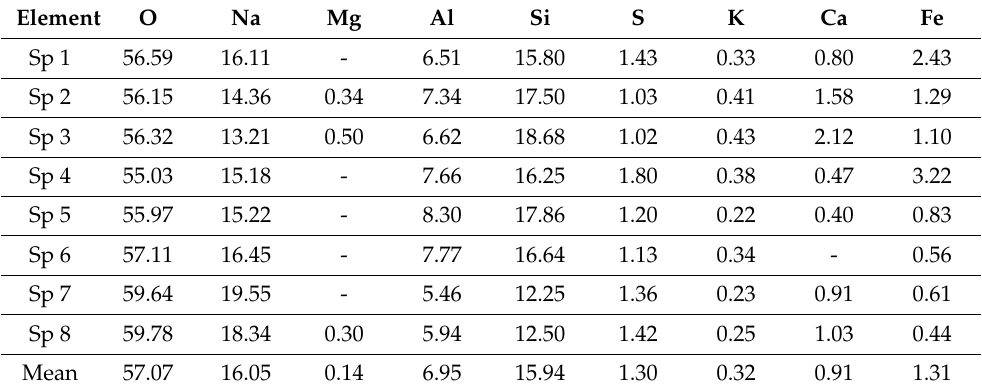
Table 6. Semi-quantitative chemical composition (given in wt %) of the eight analyzed fields on the SZ sample (spectra, Sp; analyzed with EDS).